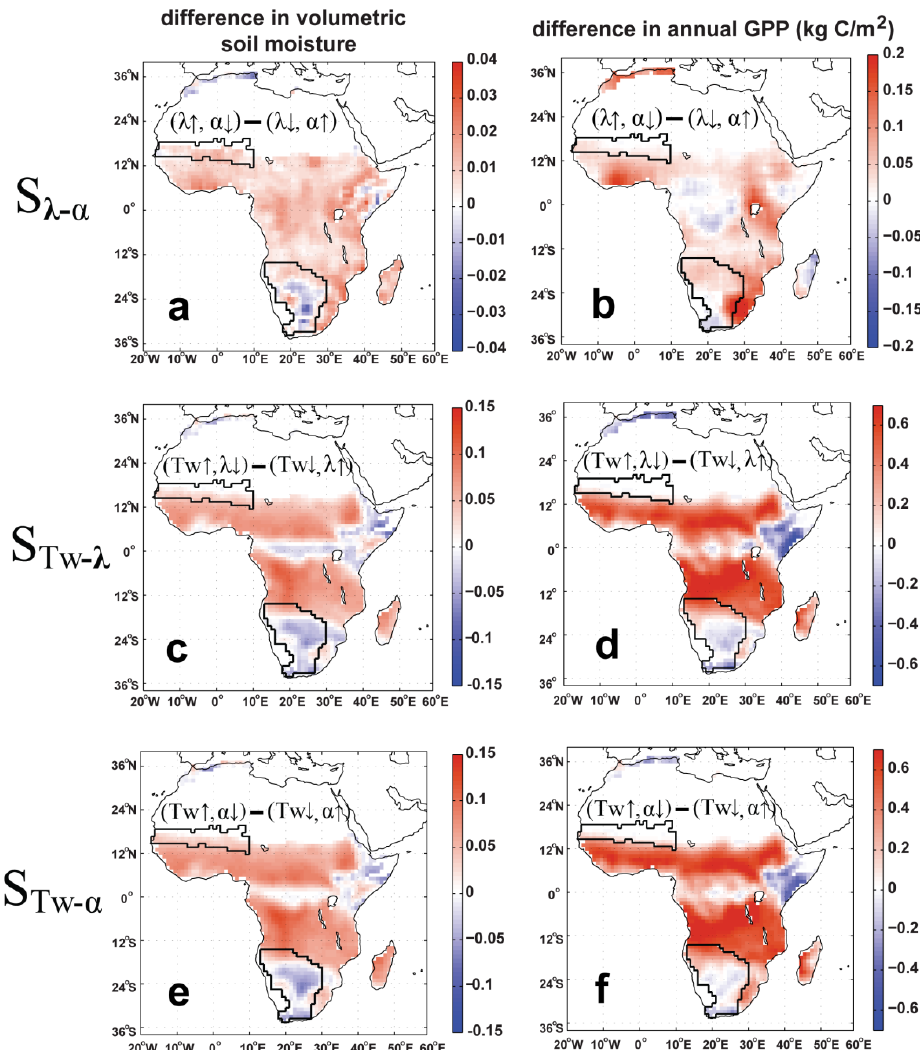
Figure 4. Simulated changes in annual mean soil moisture (0-500mm, first column) and annual mean GPP (second column) for different experiments. Please note that the scales of S λ-α is much smaller than those of S Tw-λ and S Tw-α . The two areas with black boundaries in each panel are West African grassland and Southwest African grassland associated with Figure 1. The spatial patterns shown here are smoothed by 3*3 smoothing window from the raw output.